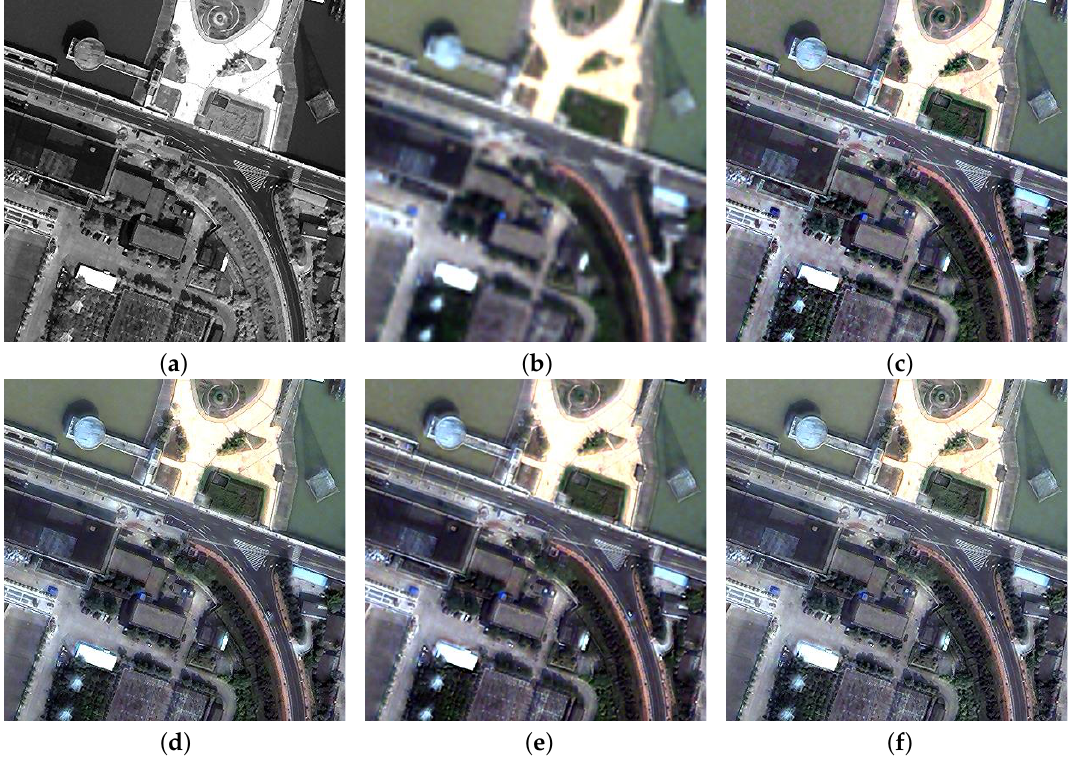
Figure 7. Visualization of QuickBird test images: ( a ) PAN; ( b ) MS; ( c ) BDSD; ( d ) MTF-GLP-HPM-PP; ( e ) PanNet; ( f )